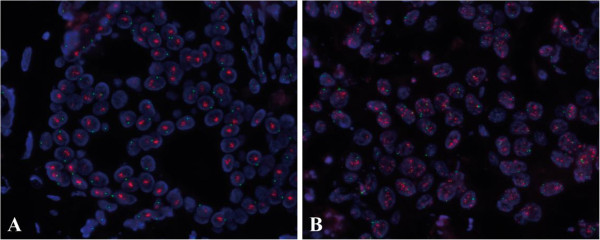
HER2 fluorescence in situ hybridization in amplified cases. A). Amplified case showing Homogeneously Staining Regions (HSR). HSR are large clusters of HER2 fluorescence signals indicating the presence of HER2 gene amplification in tandem repeats. B). Amplified case without HSR. HER2 signals are identifiable as single spots.